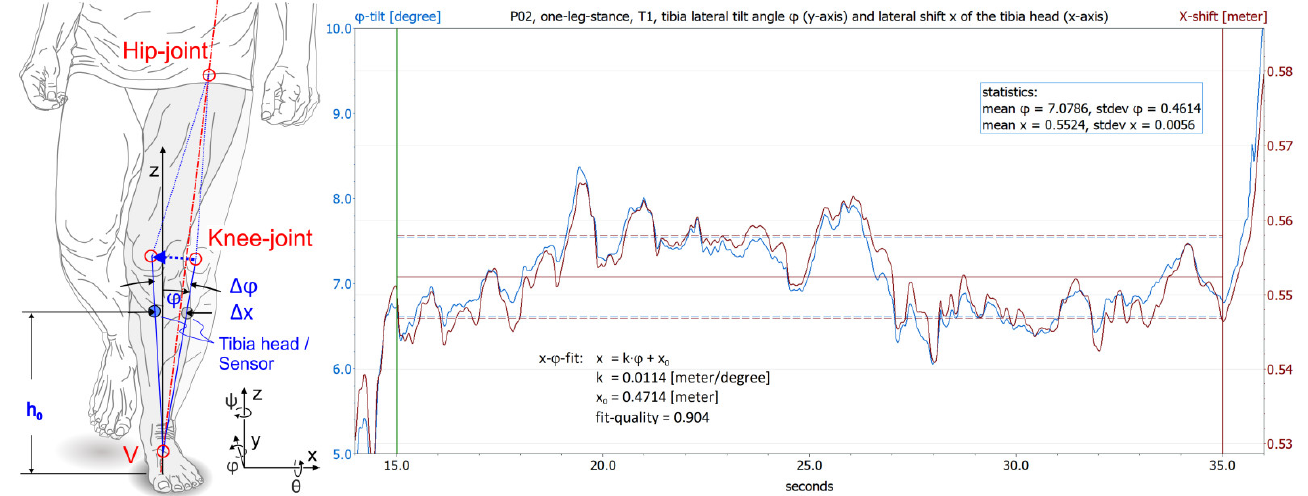
Figure 5. Left schematic: Mediolateral tilt ∆φ (13 degrees) and shift ∆x (8.5 cm) under load in One-Leg Stance (Test 5) of a hypothetical patient with knee valgus instability. Red dotted line: swivel axis through hip joint and ankle joint; vertex V on the ground. Diagram: Measured video-MA data of one of the healthy volunteers, with mediolateral tilt ∆φ (0.92 degrees) of the tibia edge (blue curve, left scale) and shift ∆x (1.1 cm) of the tibia head (red curve, right scale). Test duration, 20 s. The right scale’s range is set in such a way that the two measurement curves fit together optimally. Fit quality equals the square of the correlation coefficient.